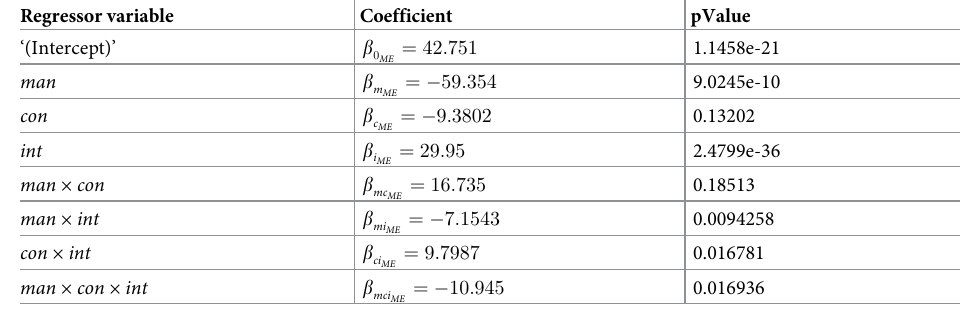
Table 1. Fixed-effects coefficients and associated p-values for the ME-task psychometric